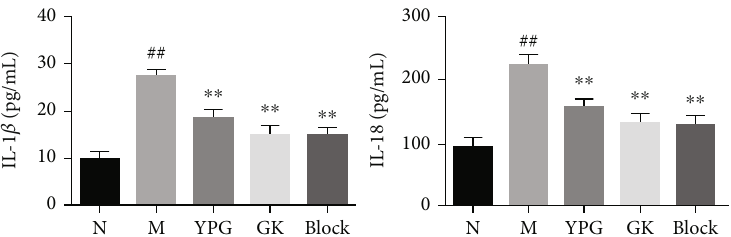
Figure 6: E ff ect of YPG on the expression of IL-1 β and IL-18 in BA rats. Notes: levels of IL-1 β and IL-18 were measured by ELISA. Data are expressed as means ± SD . n = 8 . Notes: ## P < 0 : 01 compared with the normal group; ∗∗ P < 0 : 01 compared with the model group.